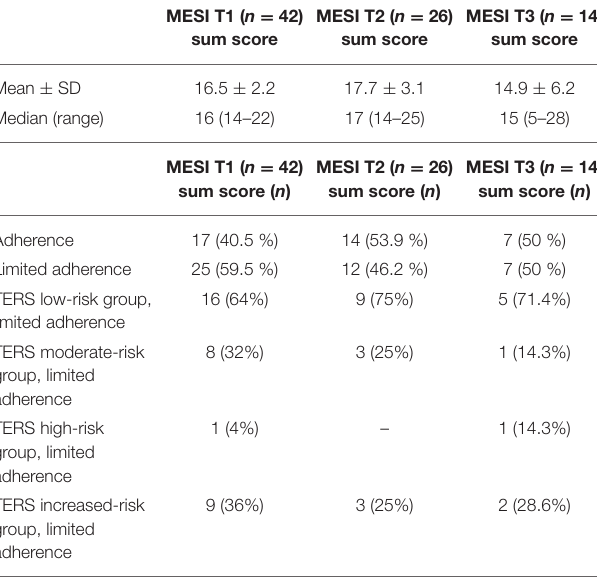
TABLE 3 | Graft-vs.-host disease (GvHD) results. TABLE 4 | Medication experience scale for immunosuppressants (MESI)